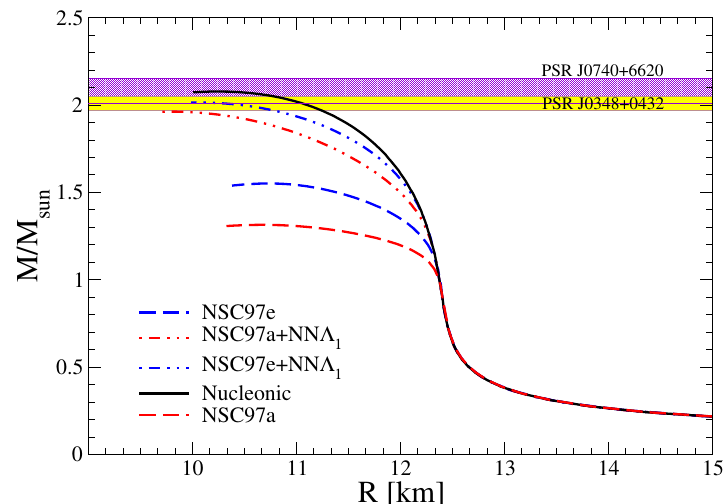
Figure 7. Mass-radius relations according to the BHF calculations proposed in Ref. [216]. The observed pulsars PSR J0348+0432 [103] and PSR J0740+6620 [104], which are represented by yellow and purple bands, respectively, indicate the uncertainty on the measurement. See text for